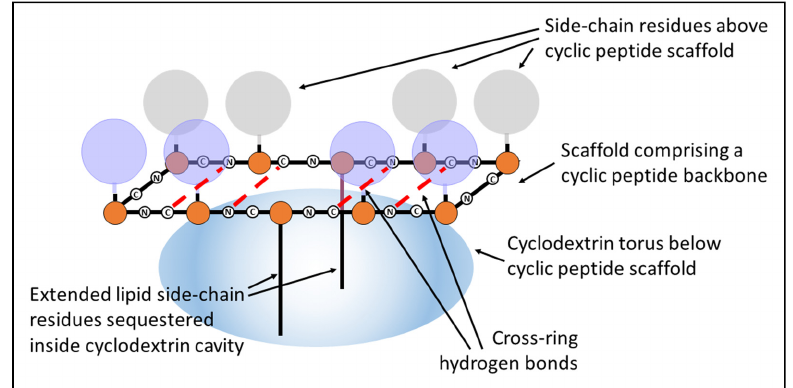
Figure 1. Structure and configuration of a peptide aptamer.